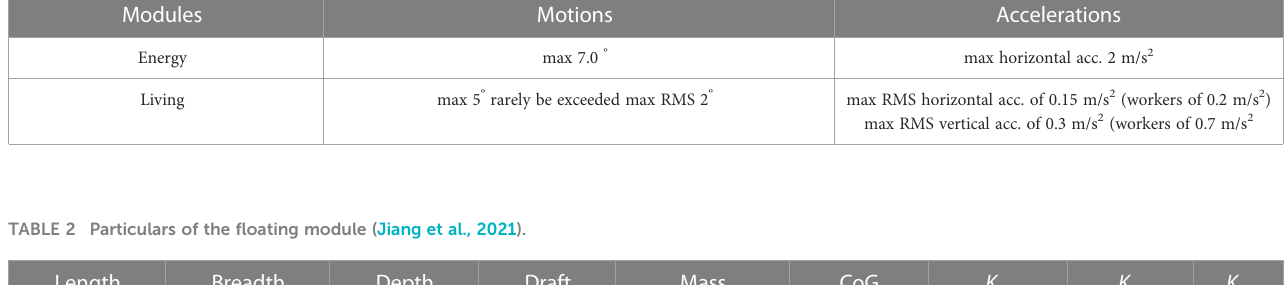
TABLE 1 Limiting criteria of the fl oating modules functioning as energy and living space. Modules